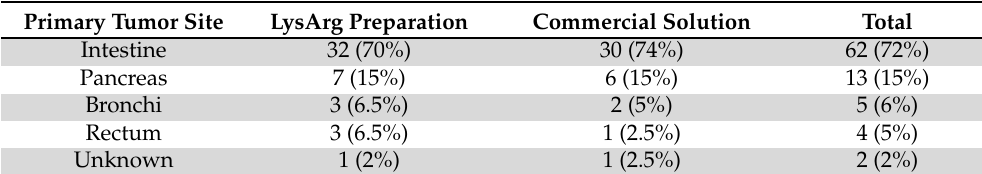
Table 3. Primary tumor site distribution in the two groups ( n = 86; 10 patients received both solutions and are counted in both groups).